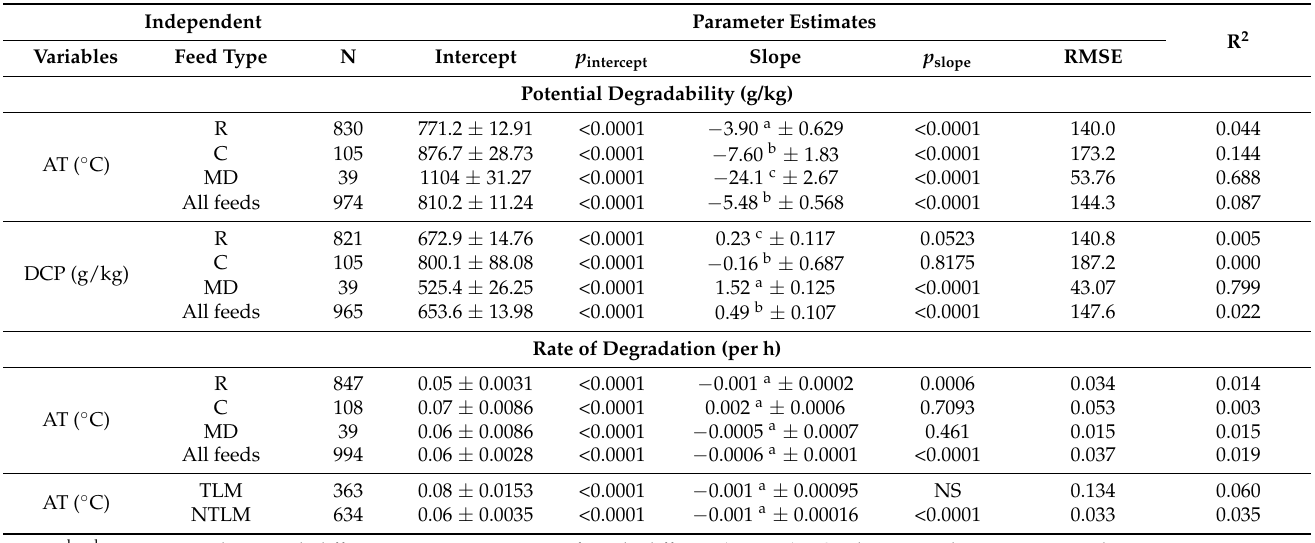
Table 5. Equations for linear regression between ambient temperature and dietary crude protein (independent variables) and slowly degradable fraction of fibre and potential degradability in the rumen.